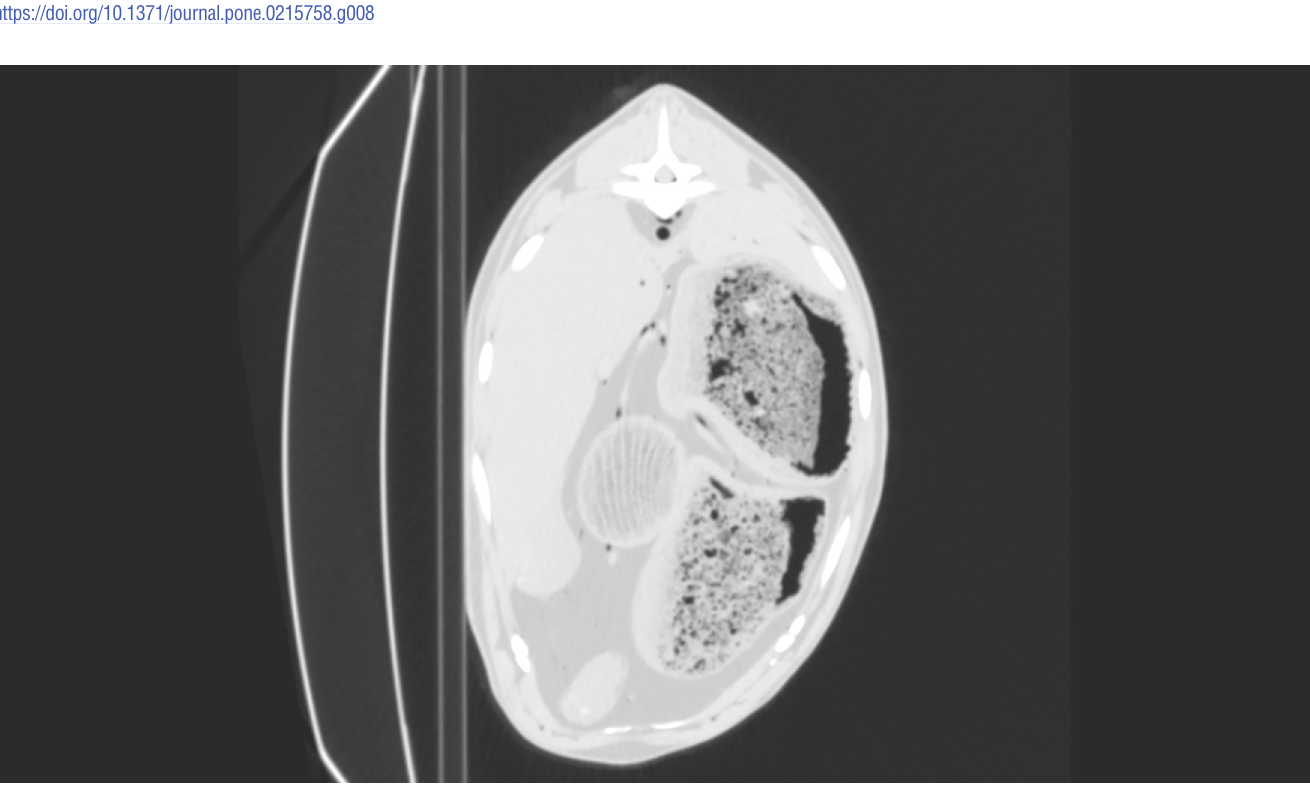
PLOS ONE | https://doi.org/10.1371/journal.pone.0215758 April 23,